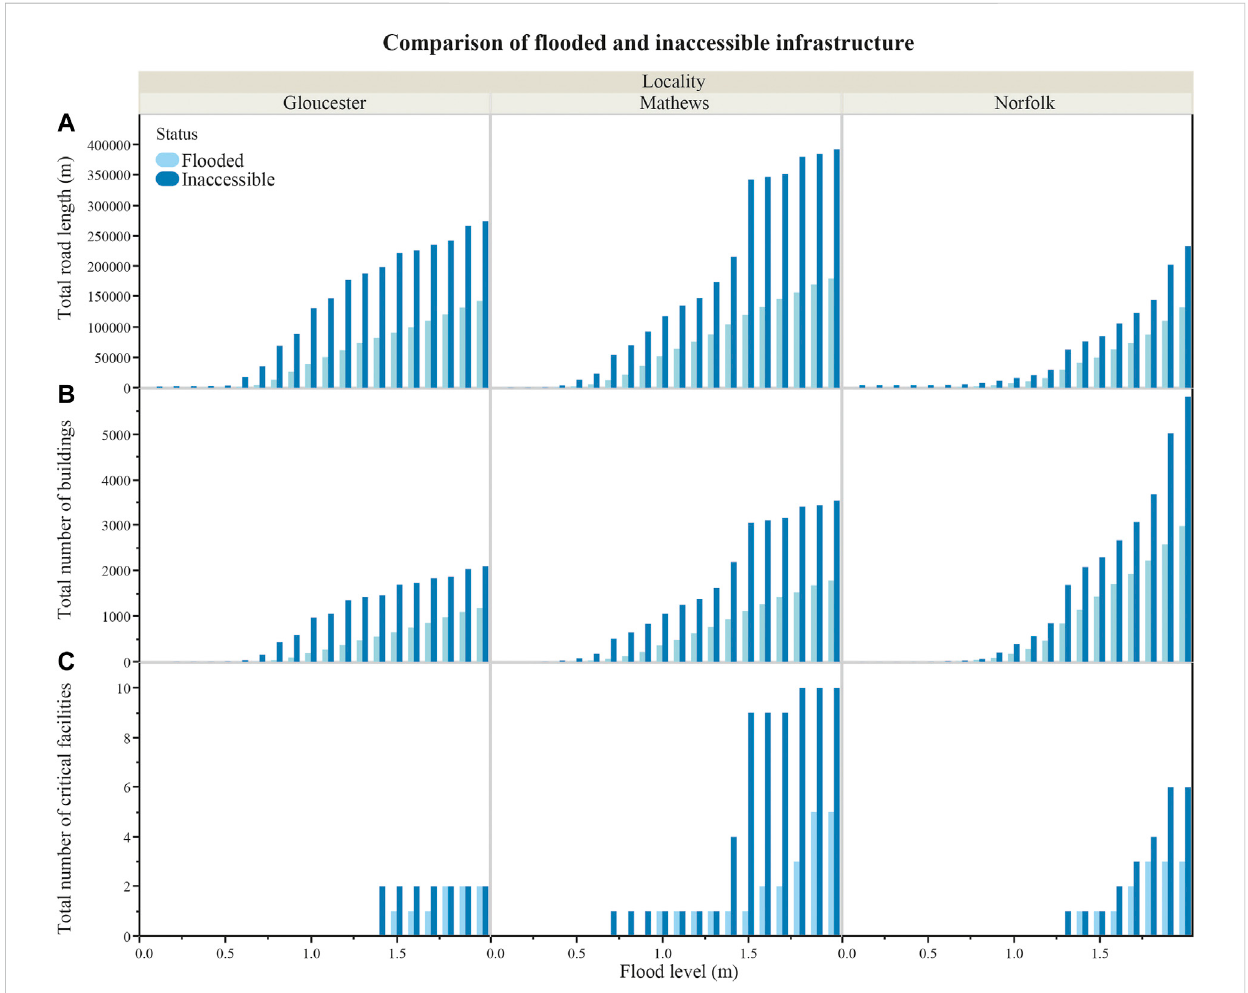
FIGURE 3 Comparisons of the impacts estimated when considering fl ooded areas with inaccessible areas. (A) The comparison of road length impacted under each scenario. Each of three test localities are shown in a separate frame, bars represent fl ooding impacts in light blue and inaccessibility impacts in dark blue. (B) The comparison of primary buildings impacted under each scenario. Each of three test localities are shown in a separate frame, bars represent fl ooding impacts in light blue and inaccessibility impacts in dark blue. (C) The comparison of numbers of critical facilities impacted under each scenario. Each of three test localities are shown in a separate frame, bars represent fl ooding impacts in light blue and inaccessibility impacts in dark